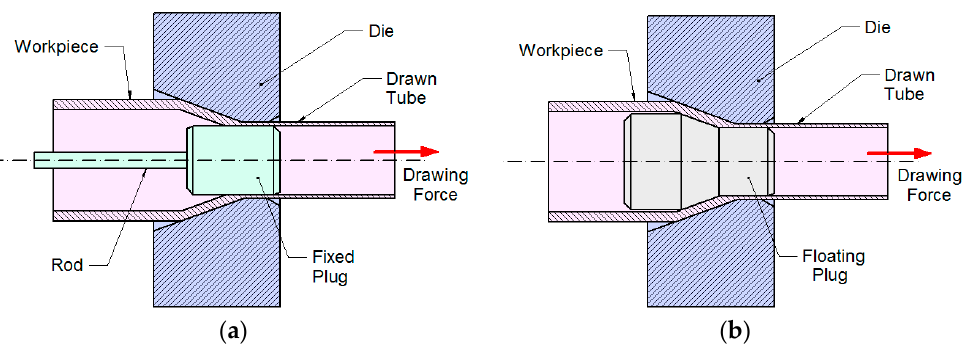
Figure 1. Tube drawing process with ( a ) a fixed plug and ( b ) a floating plug.